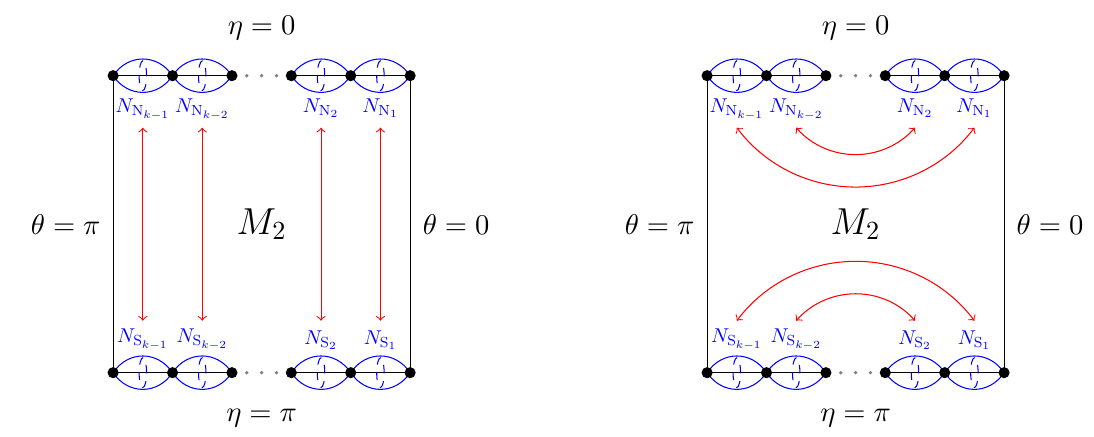
or P EW ( right ) on the ϕ ψ and N S , are 1 1